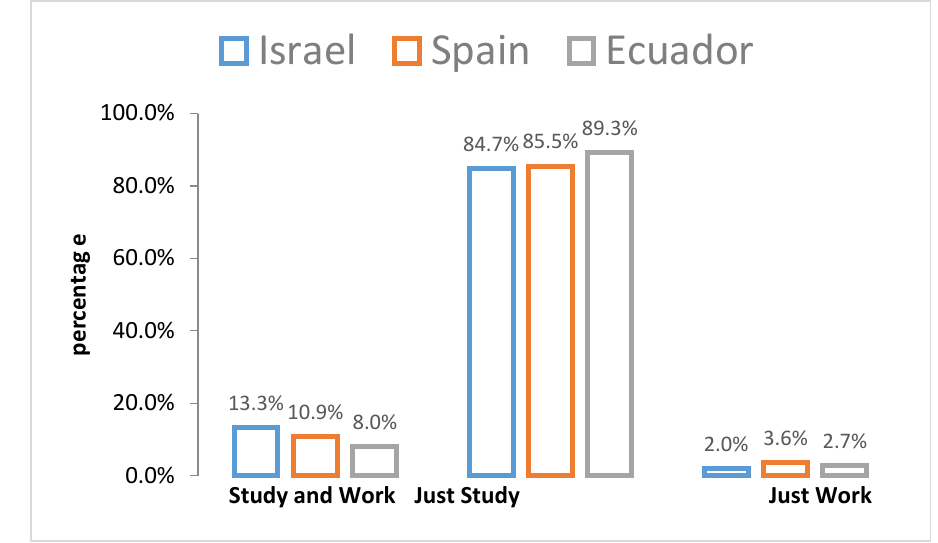
Figure 4. Occupation of the total sample.